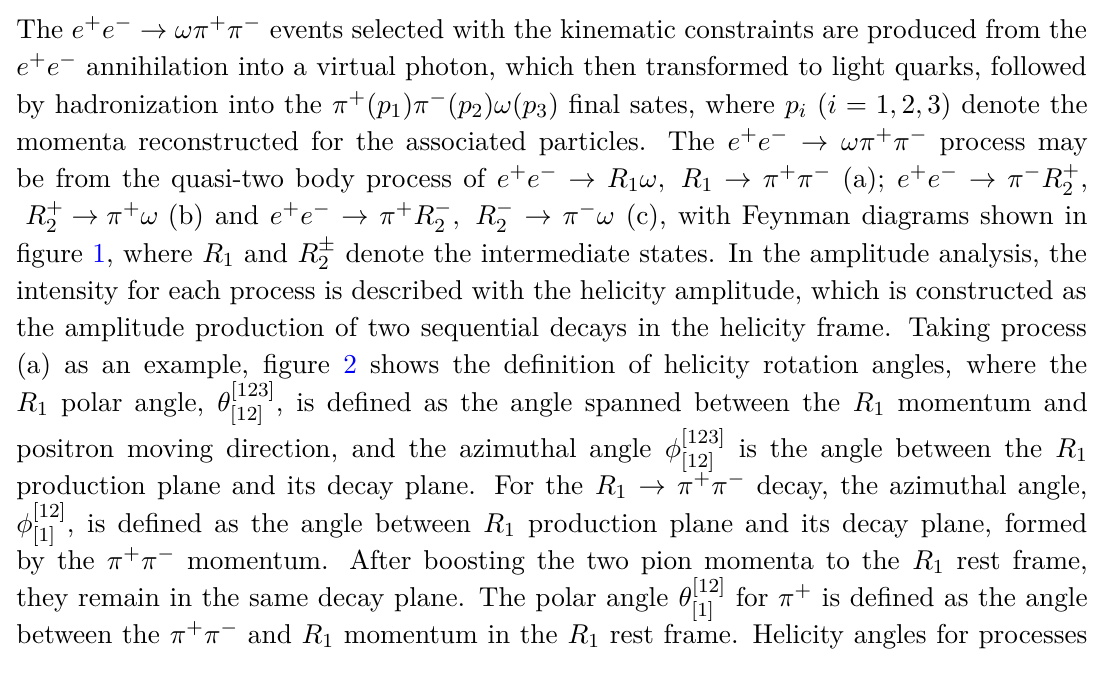
ground, the ω sidebands are defined as [0.733 , 0.758] GeV/ c 2 and [0.808, 0.833] GeV/ c 2